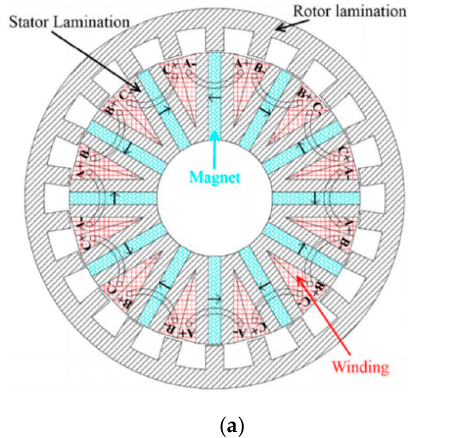
Figure 12. Configuration of an outer-rotor FSPM machine: ( a ) Cross-sectional view; ( b ) Explored view [29].